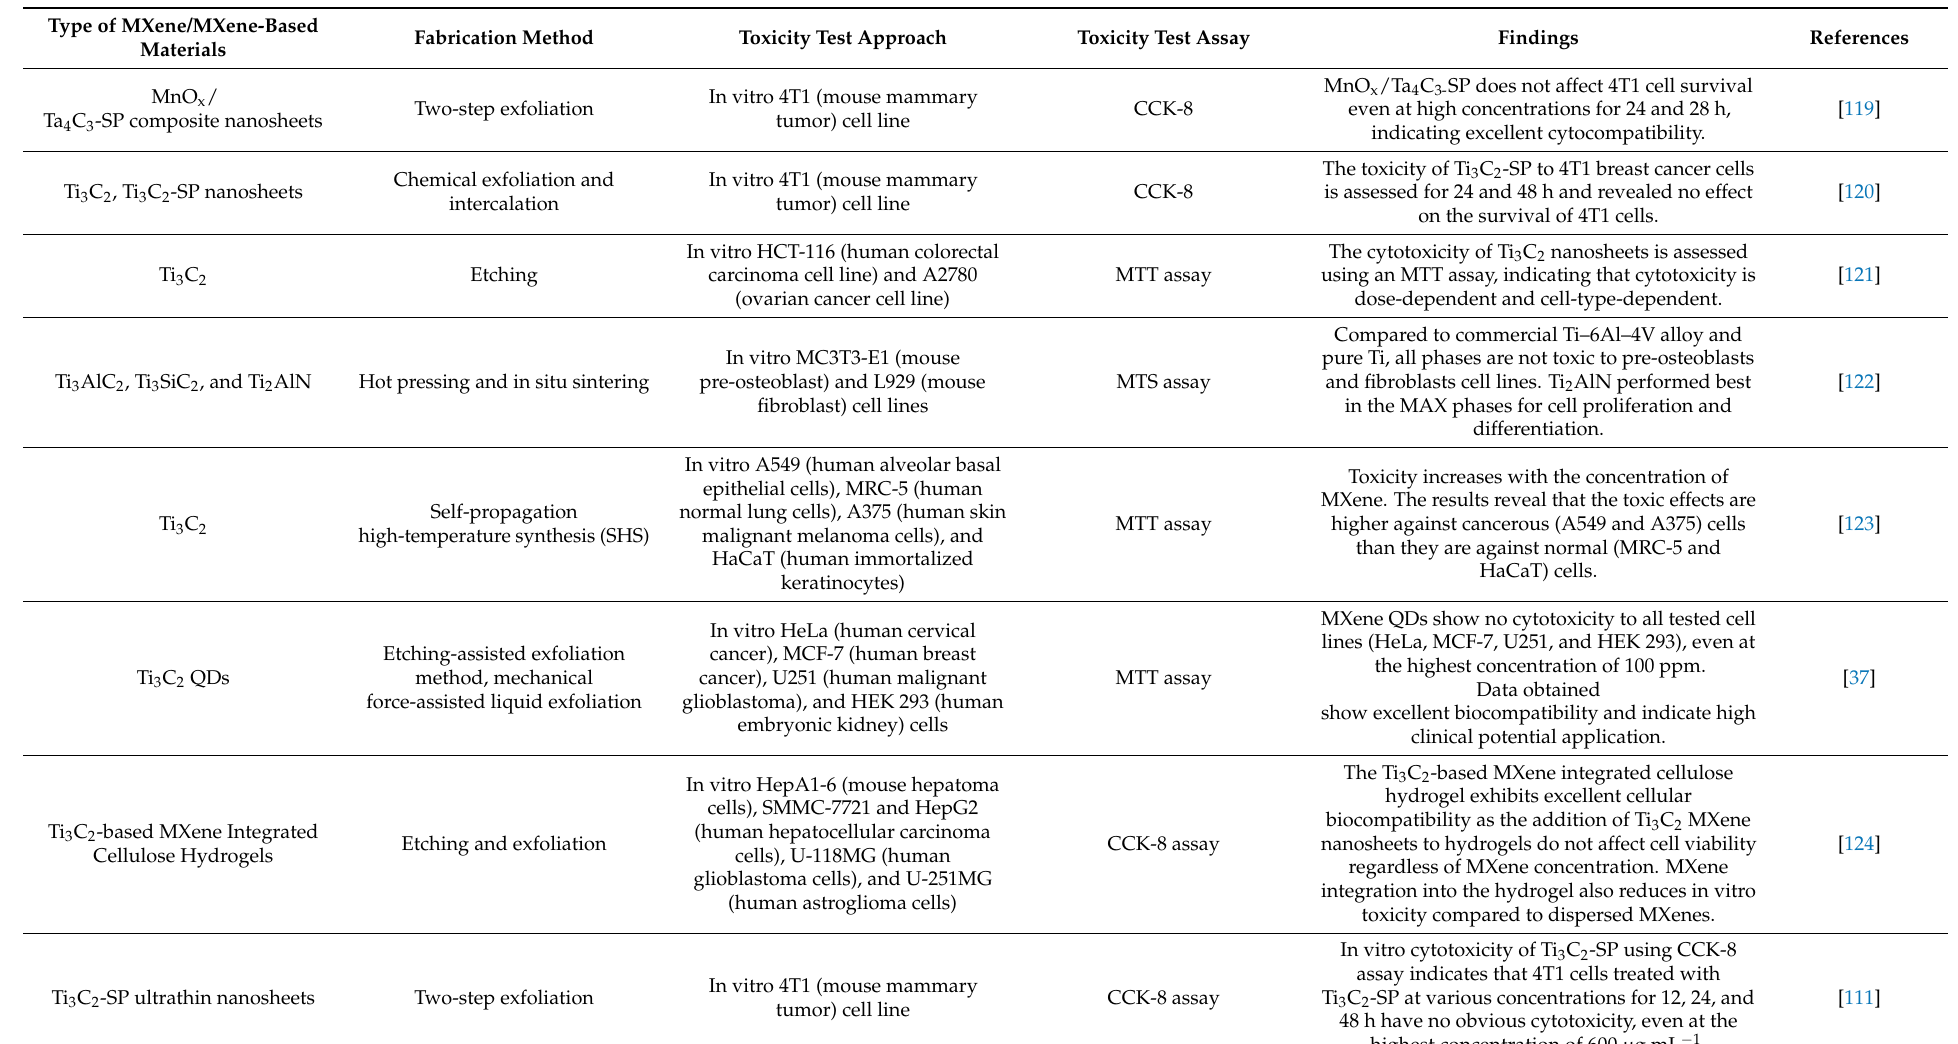
Table 1. Compilation of MXenes and MXene-based materials preparation techniques and their toxicity